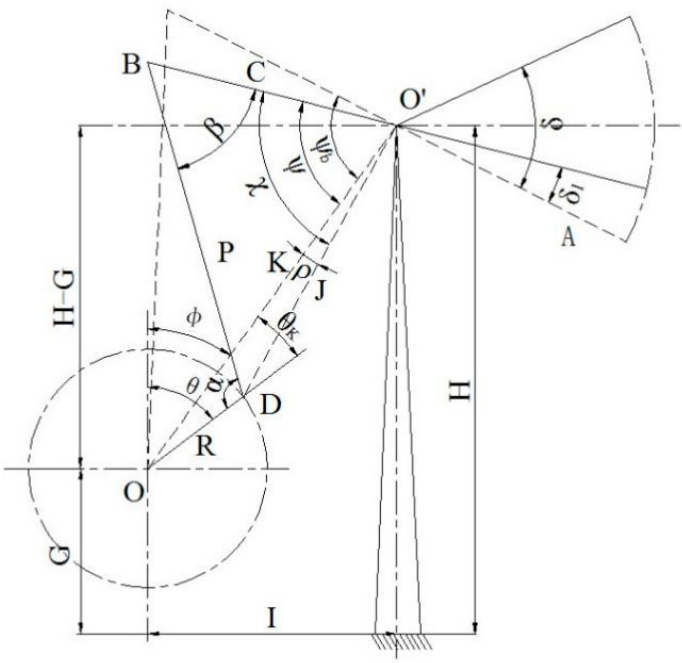
Figure 3. The motion analysis sketch of the modified pumping unit suspension point.